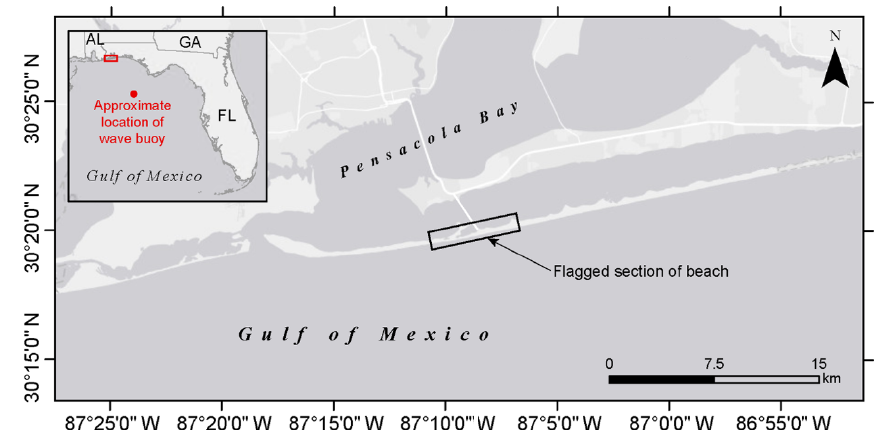
Figure 1. Map of study site showing location of the flagged section of beach and approximate location of the wave buoy used in the analysis and for regional rip forecasts (ESRI,